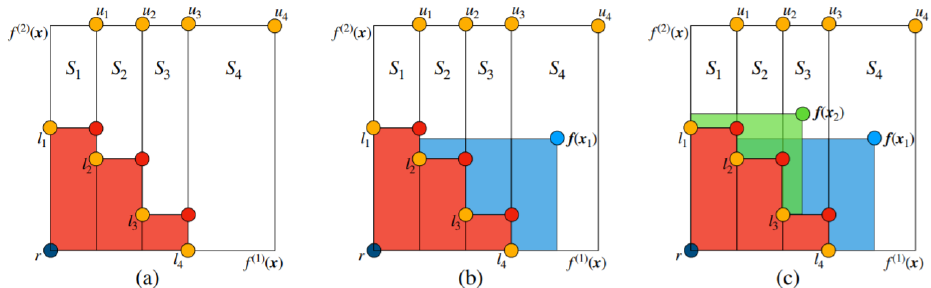
Figure 3. The initial Hypervolume ( a ). The improvement adding the point x 1 ( b ). The improvement adding the point x 2 ( c ).